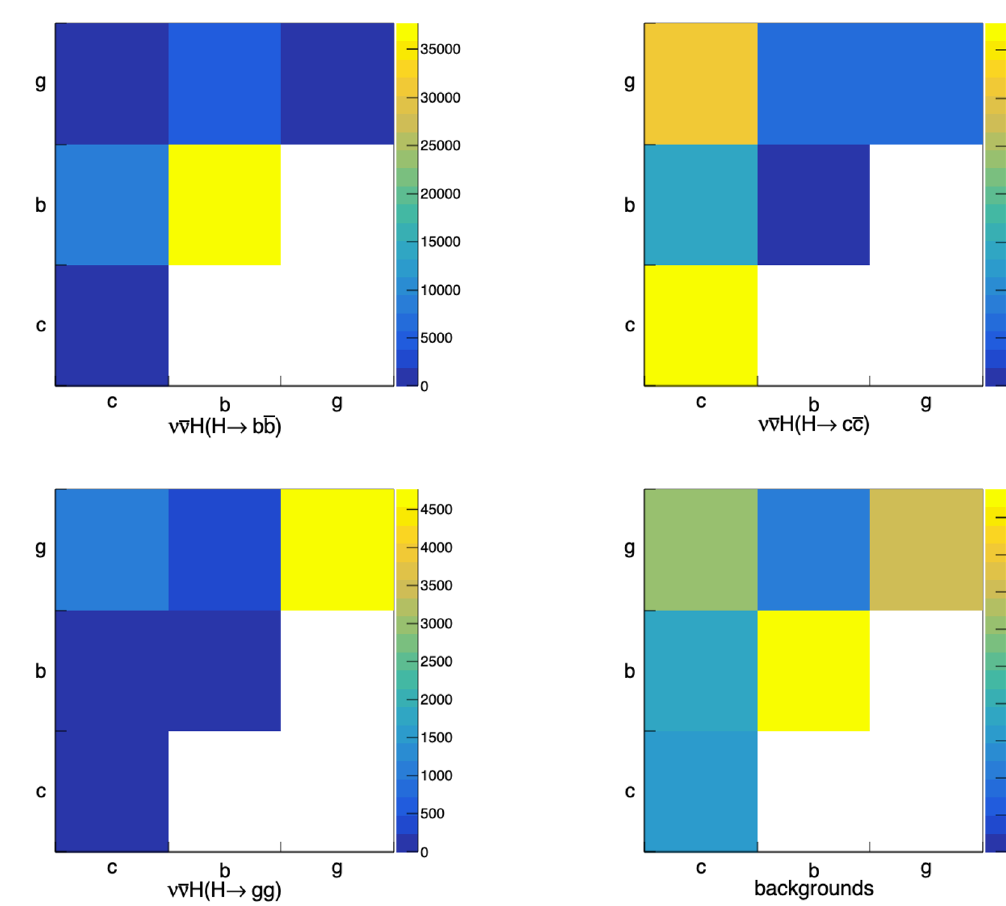
¯ b ) (top left), ν ¯ νH ( H → c ¯ c ) (top right), ν ¯ νH ( H → gg )